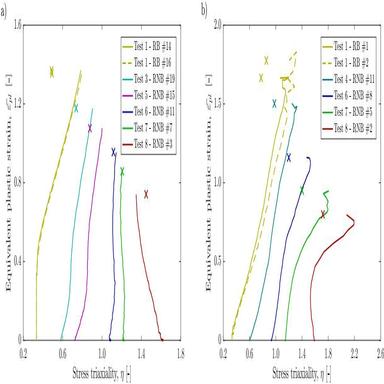
Variation of stress triaxiality with applied equivalent plastic strain for the different RNB tensile tests, the crosses represent the fracture equivalent plastic strain vs. average triaxiality (ε¯pl,f , ηav): (a) stainless steel 304L; (b) copper C110.